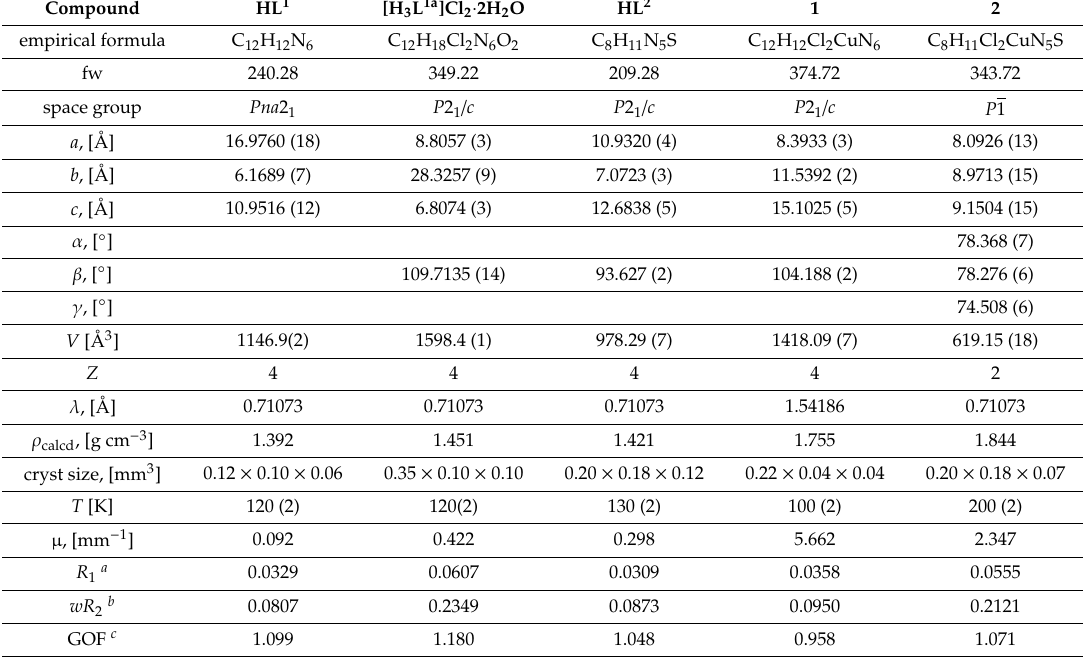
Table 1. Crystal data and details of data collection for HL 1 , [H 3 L 1a ]Cl 2 · 2H 2 O , HL 2 , [Cu(HL 1 )Cl 2 ] ( 1 ) and [Cu(HL 2 )Cl 2 ] ( 2